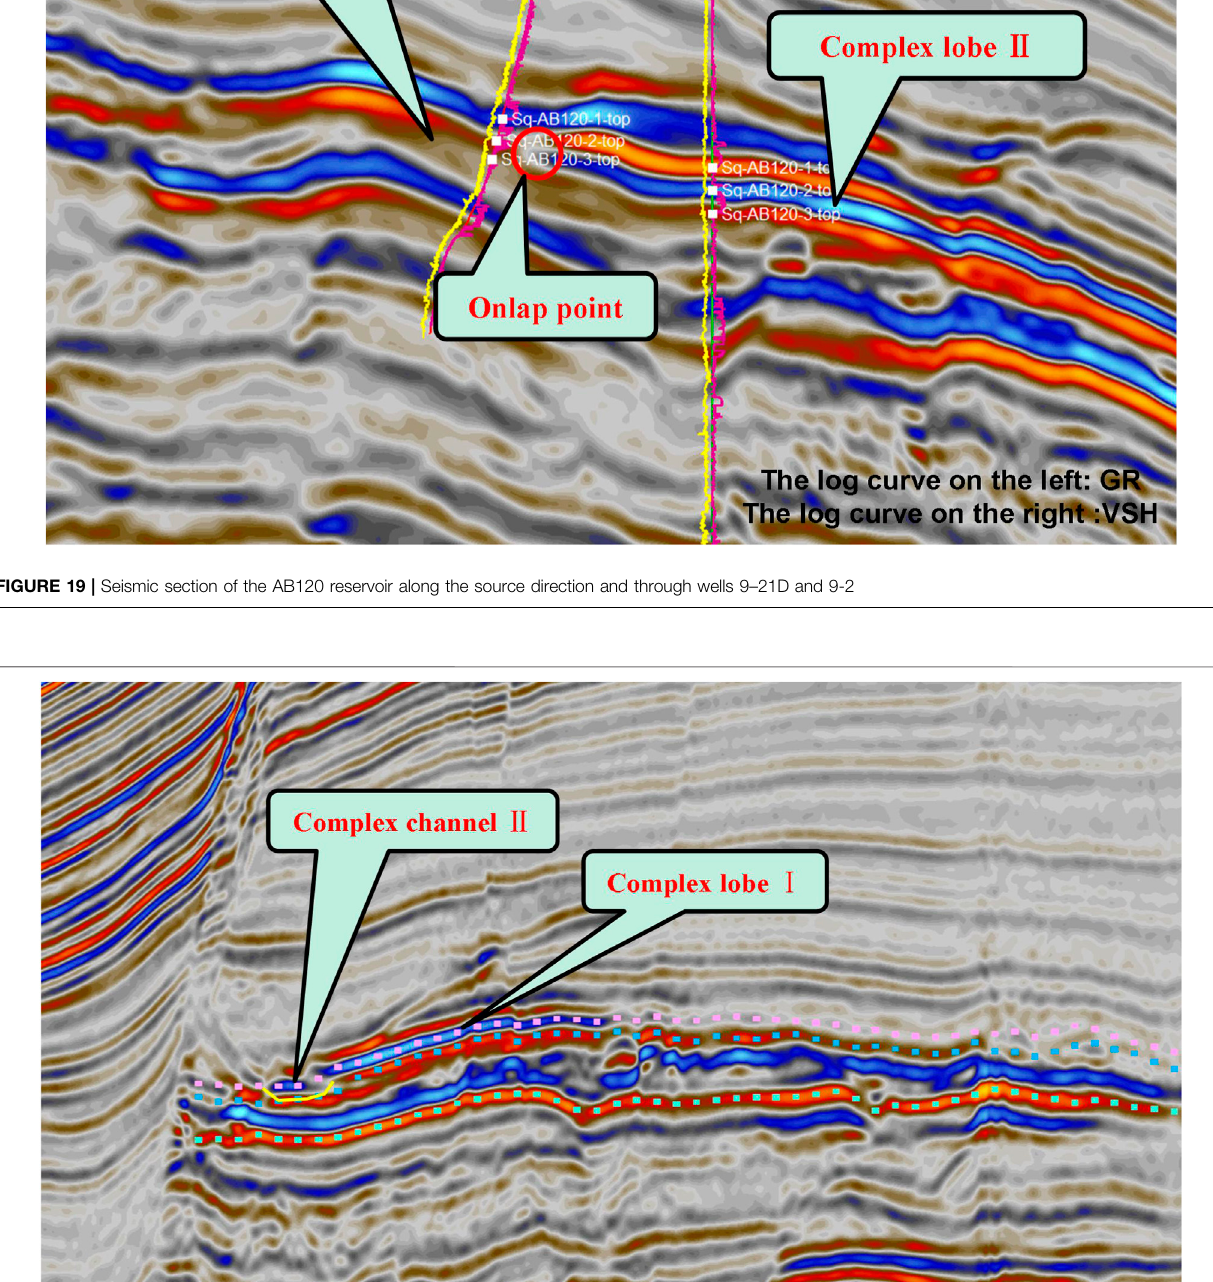
Frontiers in Earth Science |